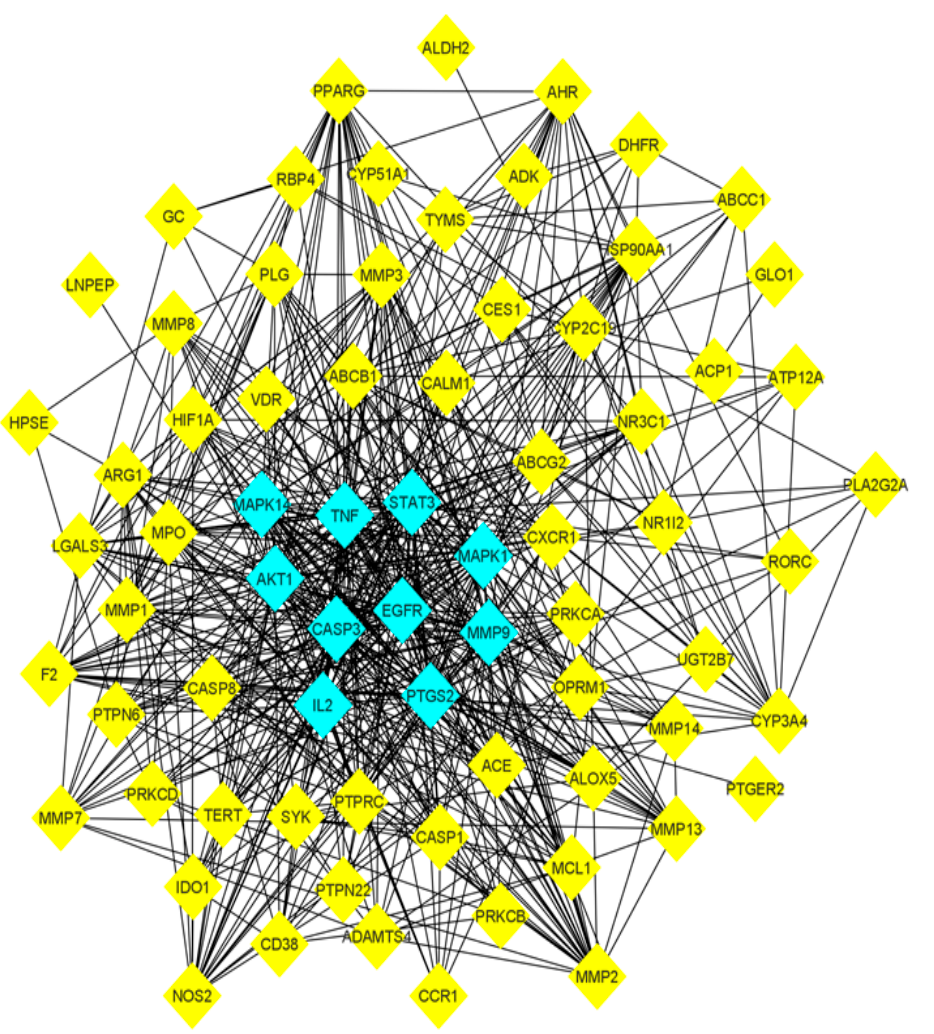
Figure 5. PPI network analysis of 72 targets. According to topological analysis, ten blue targets are key nodes (central blue nodes are hub genes with higher degree and yellow nodes represent other potential targets).